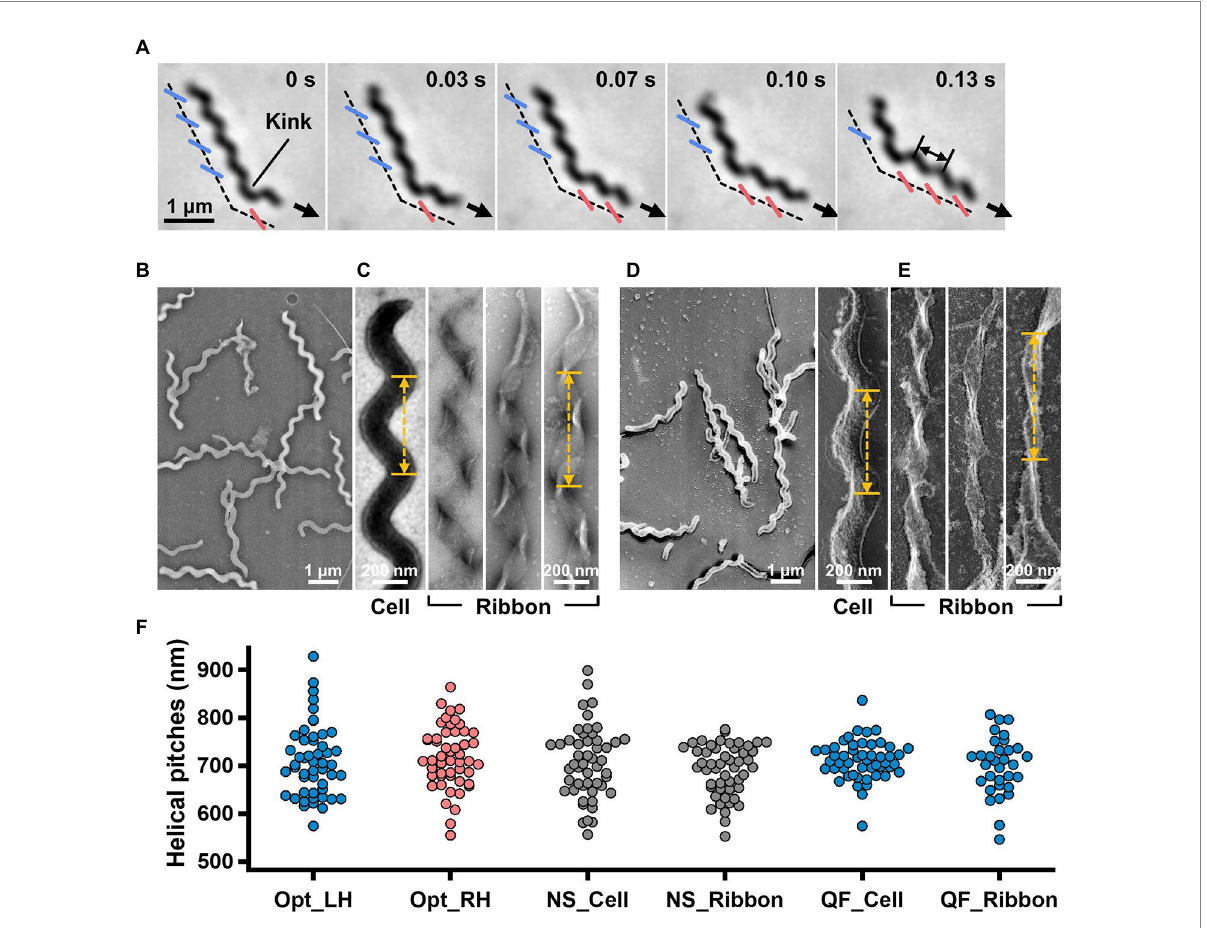
FIGURE 1 Helicity of the cell and ribbon structure. (A) Phase-contrast microscopy of swimming cell. The blue and red segments, and broken line indicate the left- and right-handed helicity, and cell axes, respectively. The pitch was measured as indicated by a double headed arrow. (B,C) Cell and ribbon images acquired by negative-staining EM. (D,E) Cell and ribbon images acquired by QFDE EM. (F) Helical pitches of cells and ribbon measured by optical microscopy, negative-staining EM, and QFDE-EM. Handedness was judged by optical microscopy and QFDE-EM. All cells analyzed by QFDE-EM were left-handed as they were grown under a starved